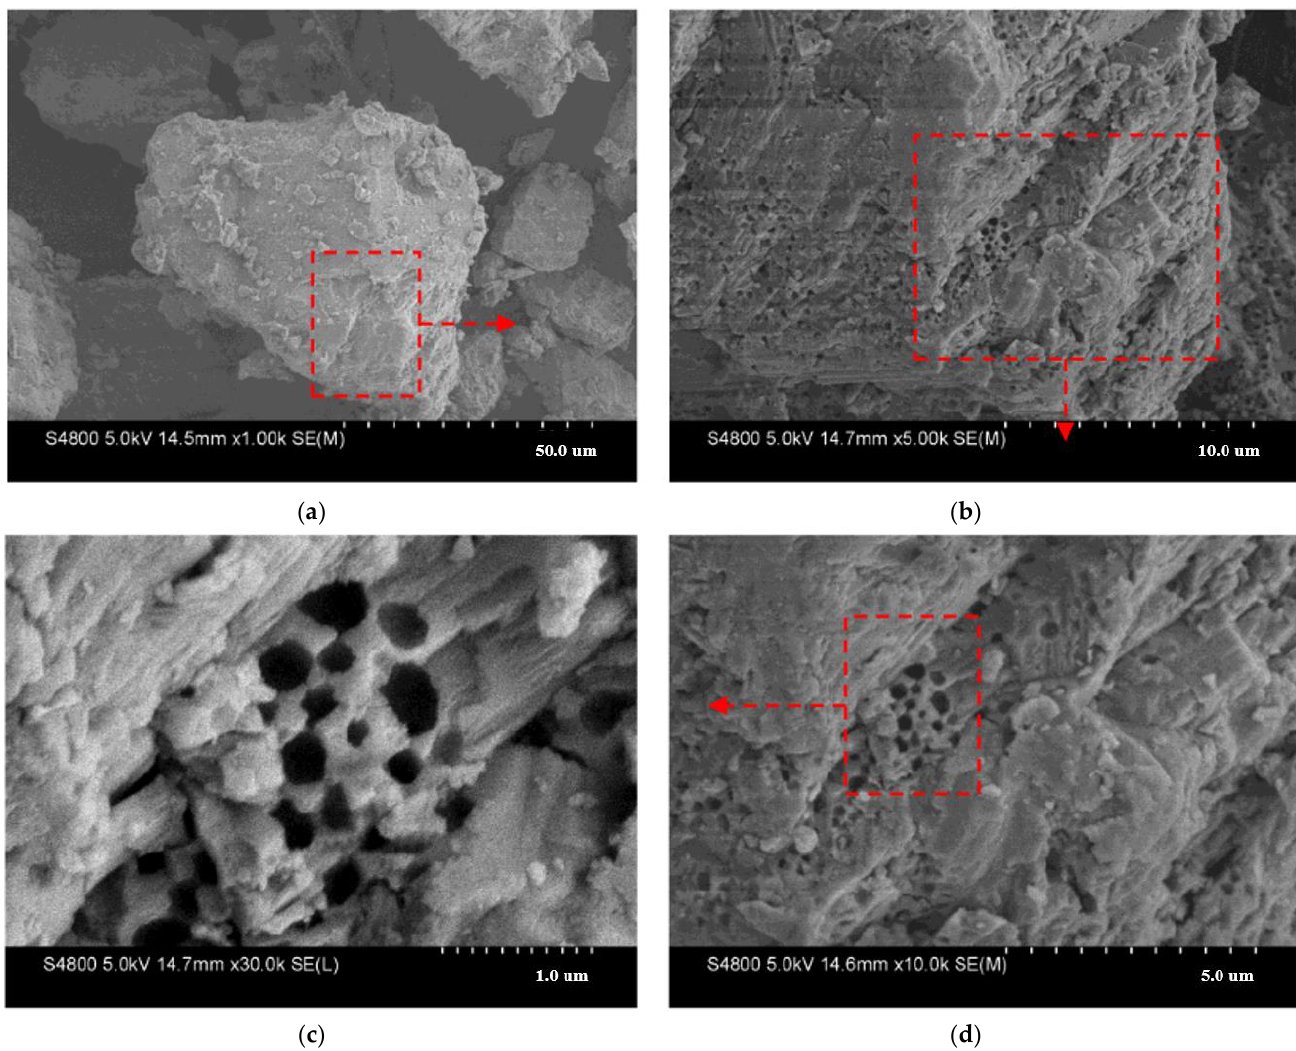
Figure 4. Microstructure image of eggshell powder: ( a ) 1000×, ( b ) 5000×, ( c ) 10,000×, ( d ) 30,000×. The part framed by red dotted lines represents observation range of particles at different multiples.